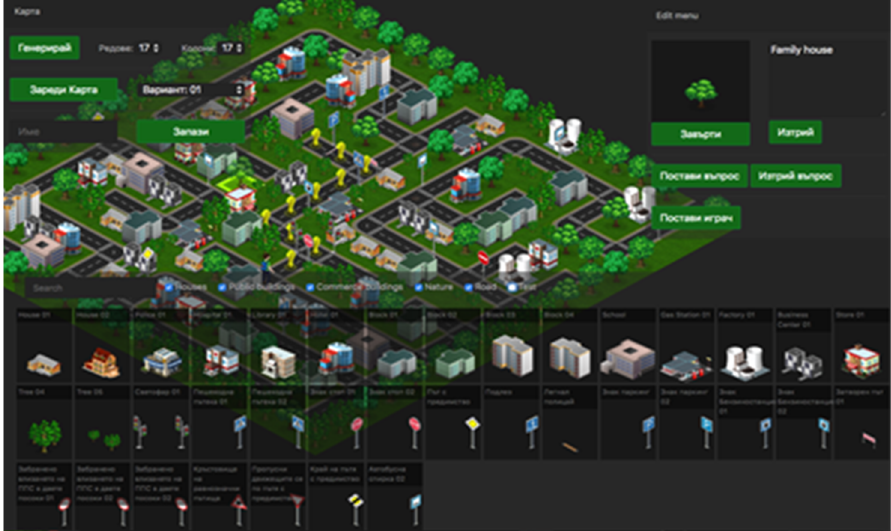
Figure 13. A visual editor for generating a virtual city model and a game scenario (in Bulgarian).